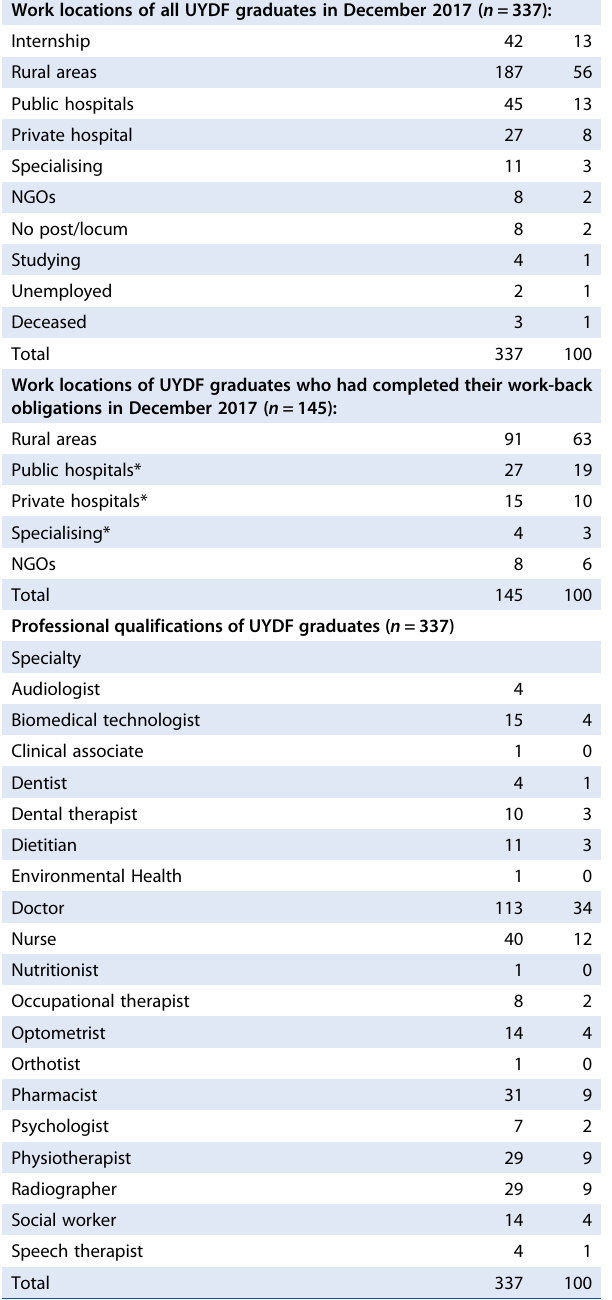
Table 1: Overview of all UYDF graduates as at December 2017